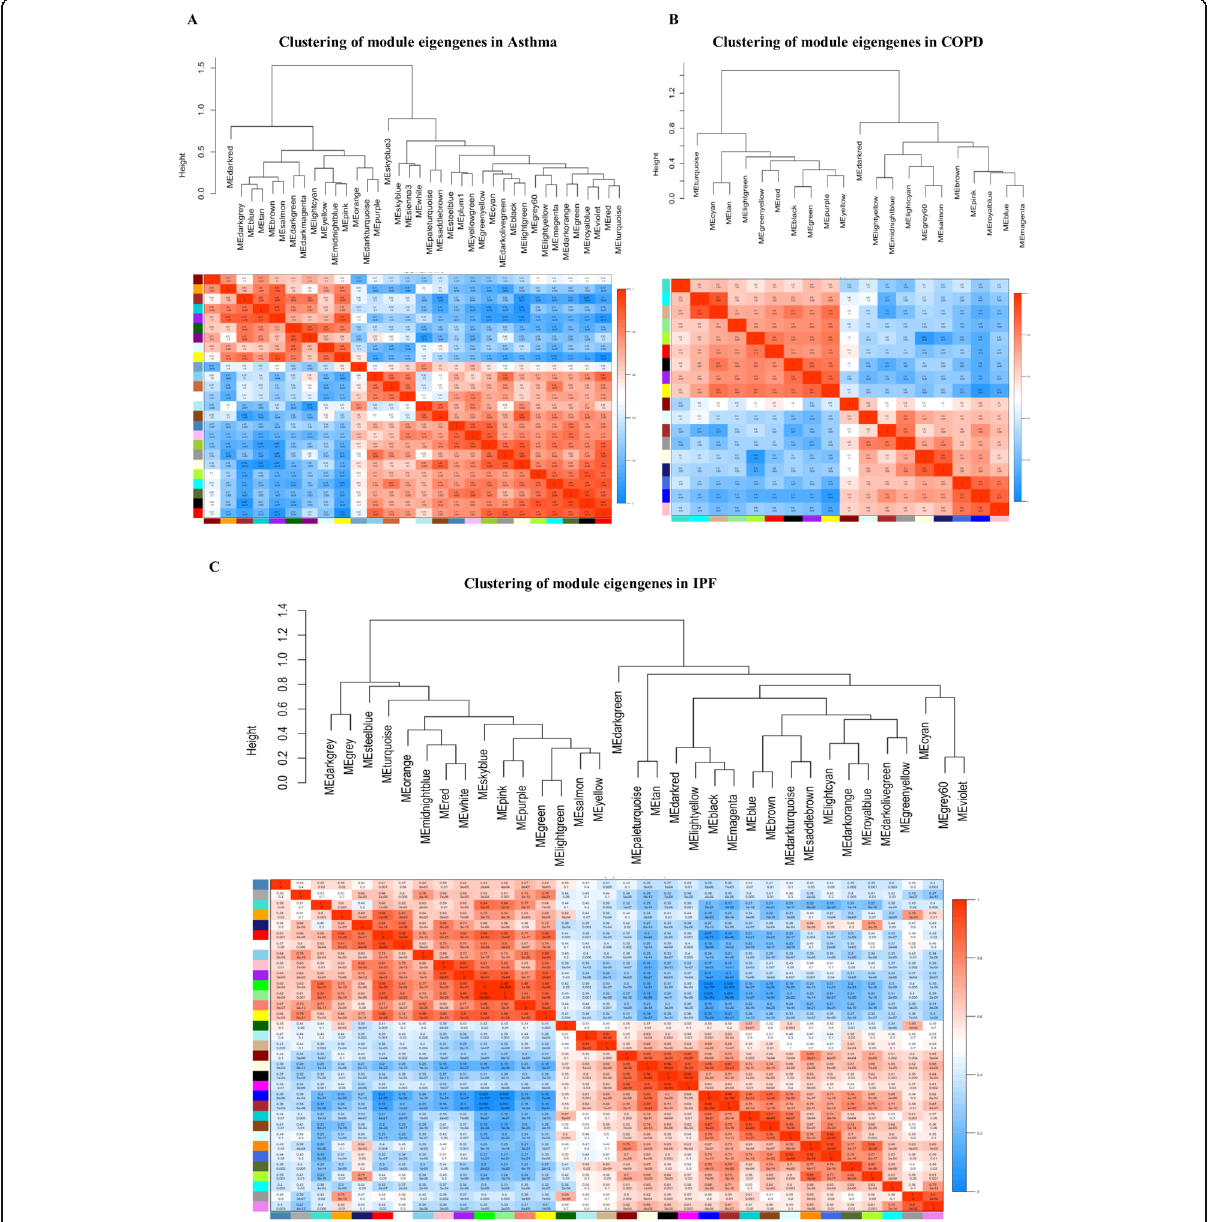
Fig. 4 Clustering and heatmap module eigengenes. a Clustering and heatmap module eigengenes in asthma, b Clustering and heatmap module eigengenes in COPD, and c Clustering and heatmap module eigengenes in